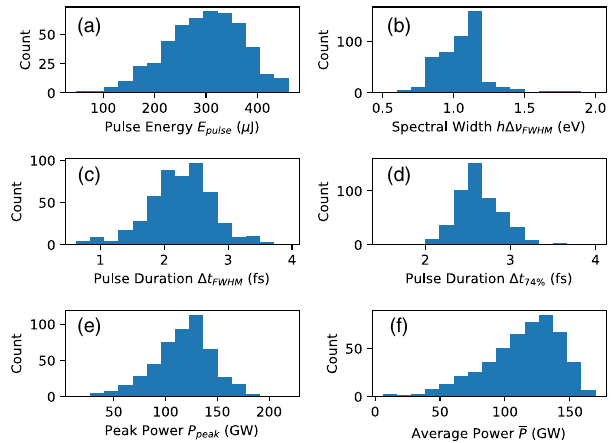
FIG. 16. Statistics of 500 shots simulation in the single- dechirper setup. Histograms of (a) the pulse energies E , pulse (b) the spectral widths h Δ ν defined as the FWHM in the FWHM frequency domain, (c) the pulse durations Δ t defined as the FWHM FWHM in the time domain, (d) the pulse durations Δ t 74% defined as the shortest duration containing 74% of the pulse energy, (e) the peak powers P , and (f) the average pulse power of each peak ¯ P ¼ E = Δ t XFEL shot defined as 74% pulse